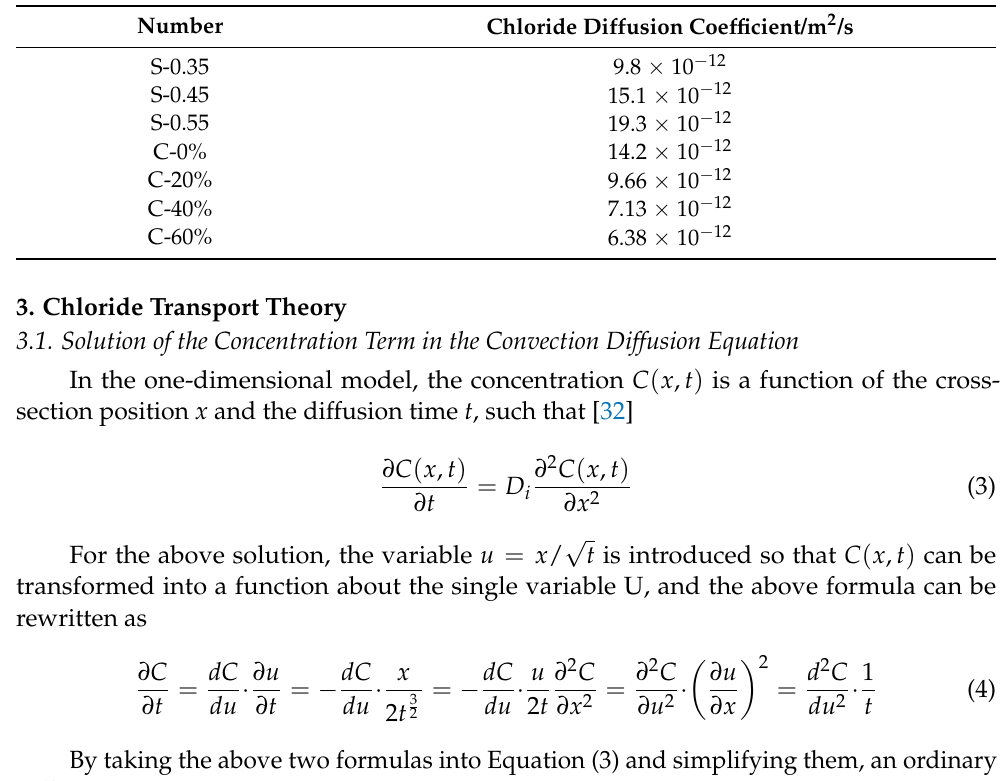
Table 5. Measured values of the chloride diffusion coefficients of cement-based